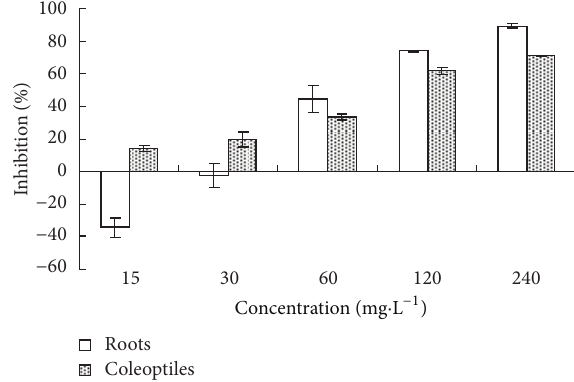
Figure 4: Bioassay of 5-fluoro-2-hydroxy butyrophenone on seedling growth of Echinochloa crusgalli